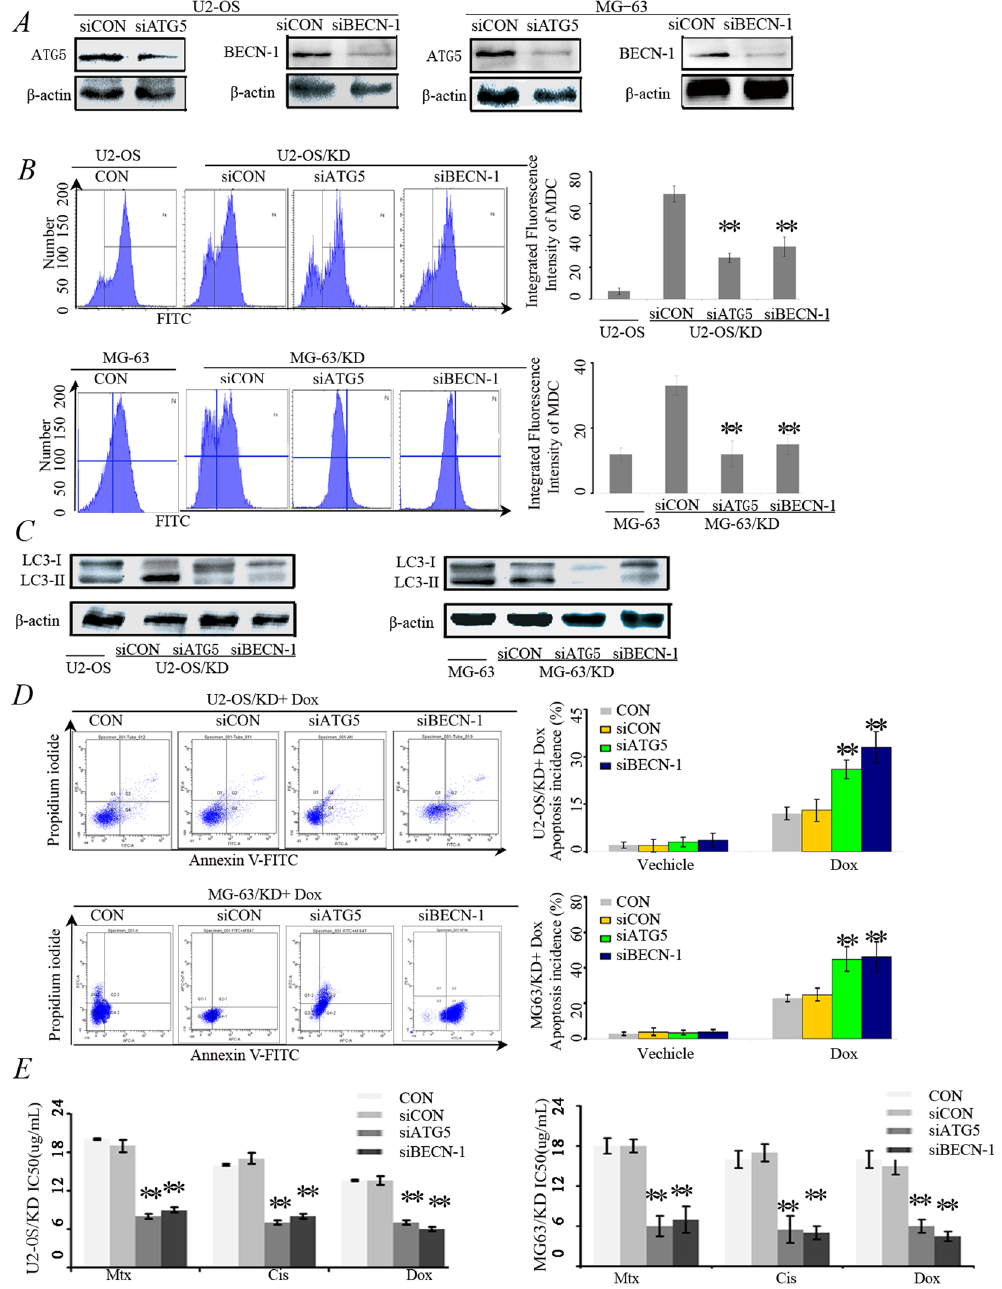
Figure 5. Inhibition of autophagy restored the chemosensitivity of U2-OS/KD and MG-63/KD cells. ( A ) Western blot analysis for the expression of BECN-1 and ATG5 proteins. U2-OS/KD cells and MG-63/KD were co-transfected with BECN-1 siRNA (siBECN-1) or ATG5 siRNA (siATG5). After 48 hrs, BECN-1 and ATG5 proteins were detected using Western blot. ( B ) Flow cytometry assay to detect autophagy level using by MDC staining. Cells were described as ( A ). ( C ) Western blot analysis for the expression of LC3-II/I proteins. ( D ) Flow cytometry for apoptosis analysis using Annexin V-FITC/PI double staining. U2-OS/KD cells and MG-63/KD were co-transfected with siBECN-1 or siATG5. After 48 hrs, the cells were treated with 1 μ M Dox for 24 hrs. ** P < 0.05 versus U2-OS/KD cells treated with